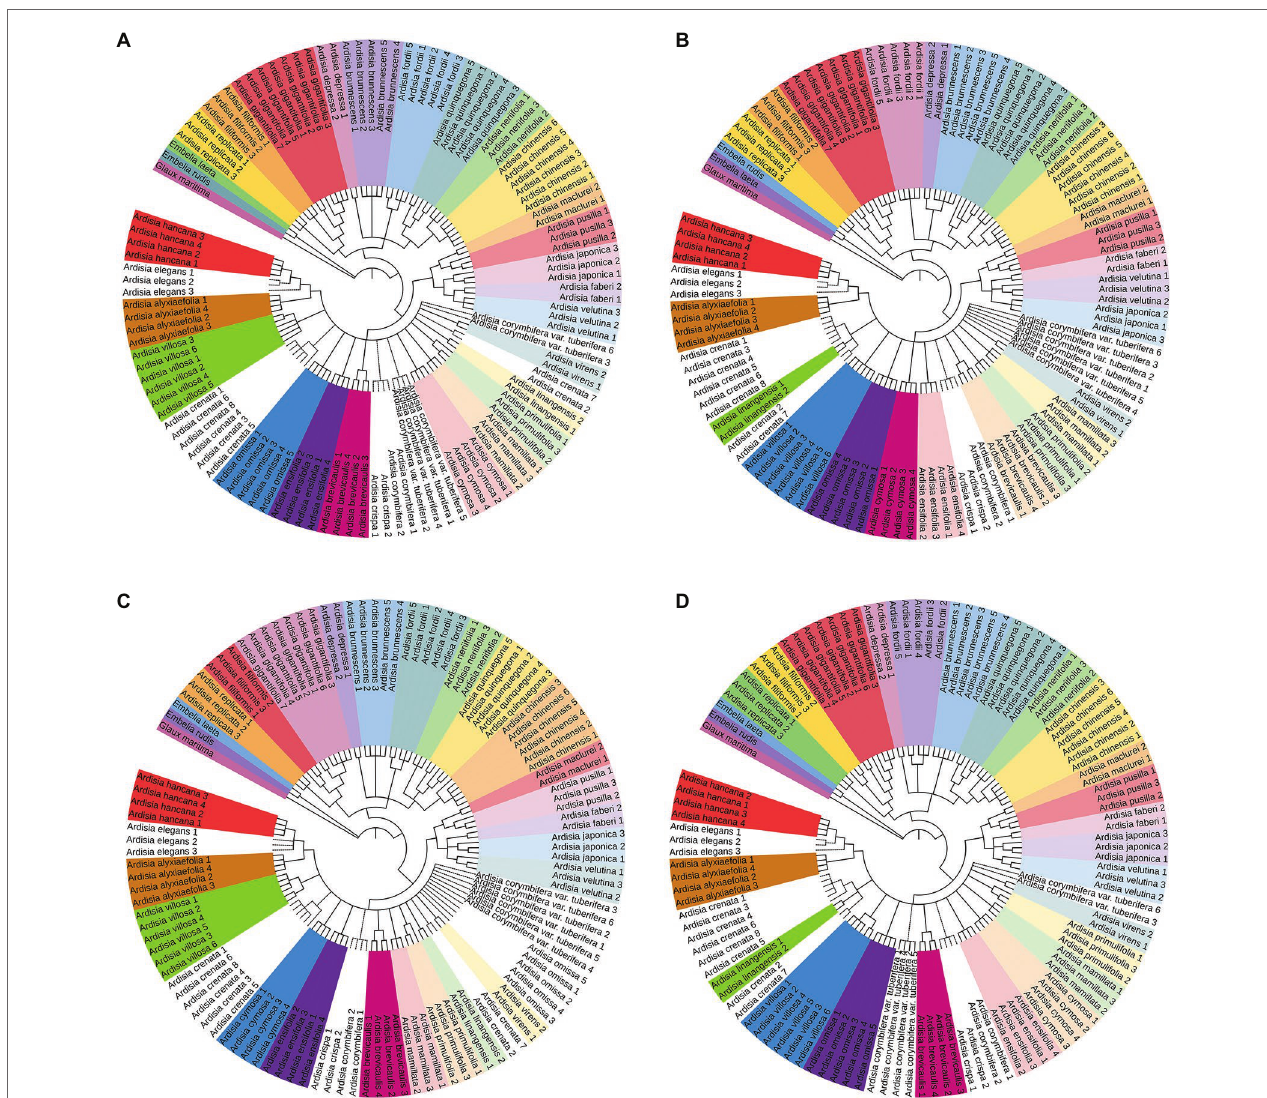
FIGURE 3 | The NJ tree based on other four sequences. Successfully identified species are with bootstrap values above 60%. The dotted line indicates unsuccessful identified species. (A) The NJ tree based on ITS + psb A- trn H + rbc L sequences, (B) the NJ tree based on ITS + mat K + psb A- trn H sequences, (C) the NJ tree based on ITS + mat K + rbc L sequences, (D) the NJ tree based on ITS + psb A- trn H + mat K + rbc L